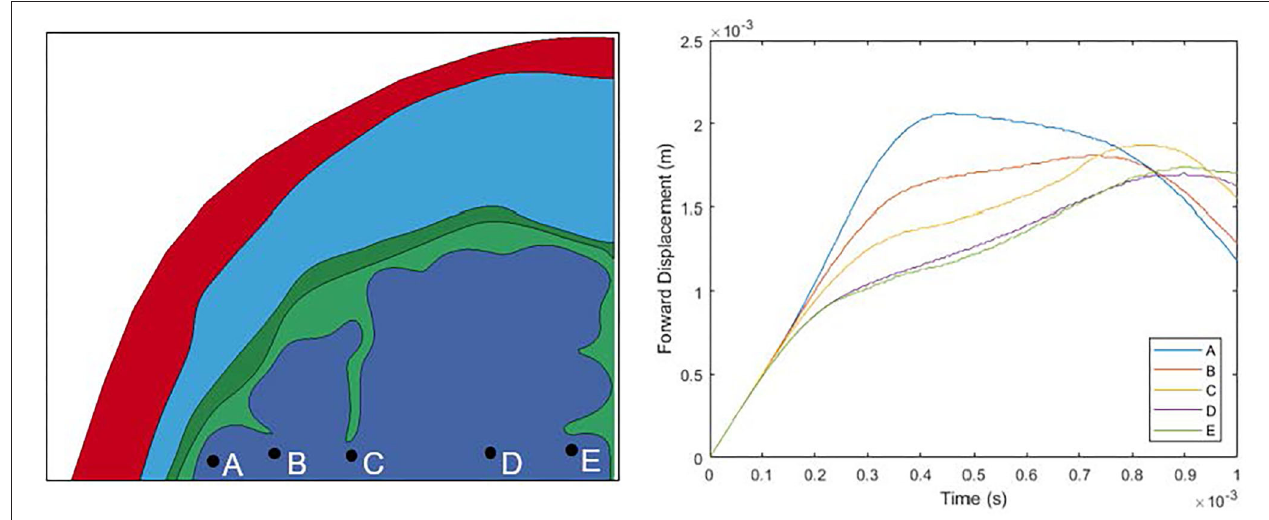
FIGURE 14 | Motion of the brain throughout the duration of the